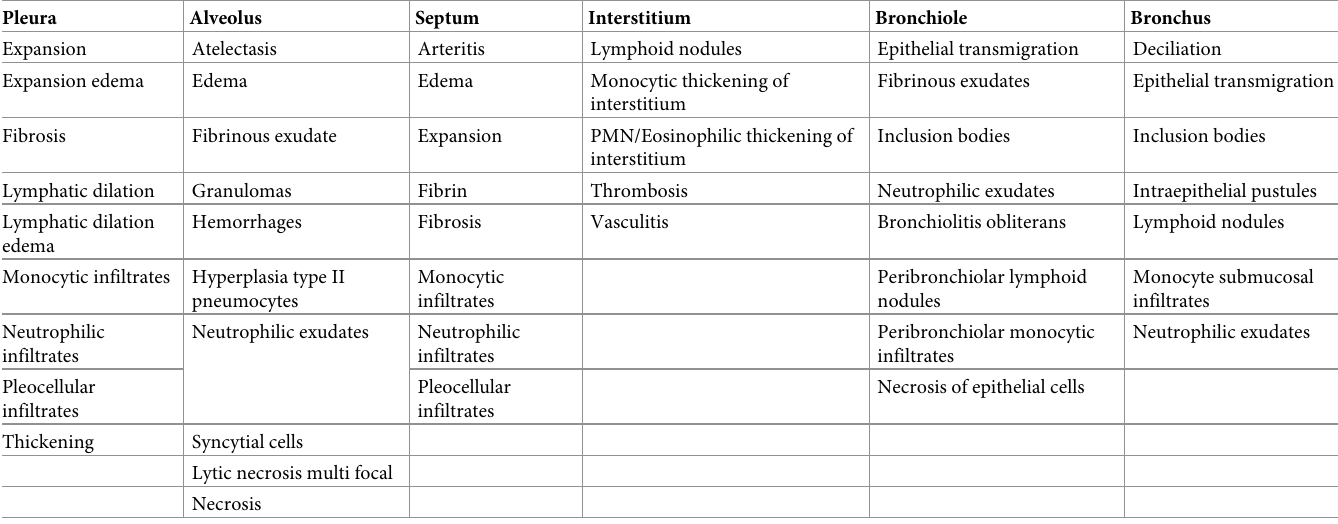
Table 2. Specific histological findings sought and scored for each structure on each